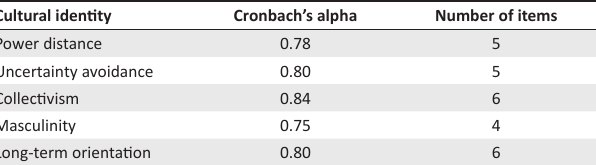
TABLE 5: Reliability data ( N =